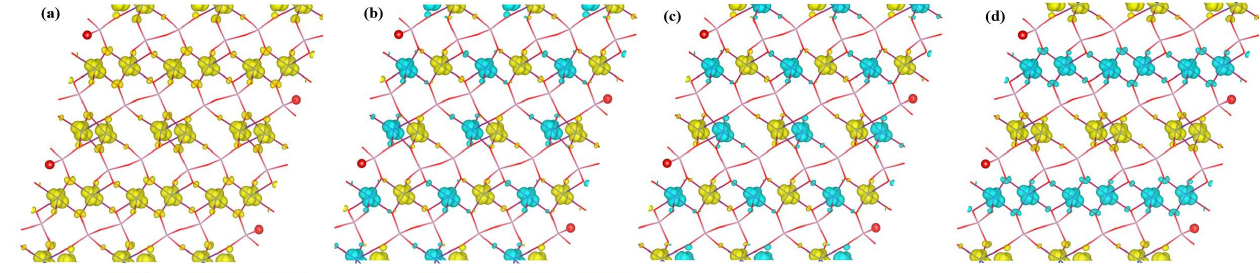
Figure 5. Spin density of α -Cu 2 P 2 O 7 in ( a ) FM, ( b ) AFM-1, ( c ) AFM-2 and ( d ) AFM-3 states of magnetic order, as calculated within HSE density functional. The isosurface level of the charge density is set at 0.2 e /Å 3 ; the image is produced using VESTA